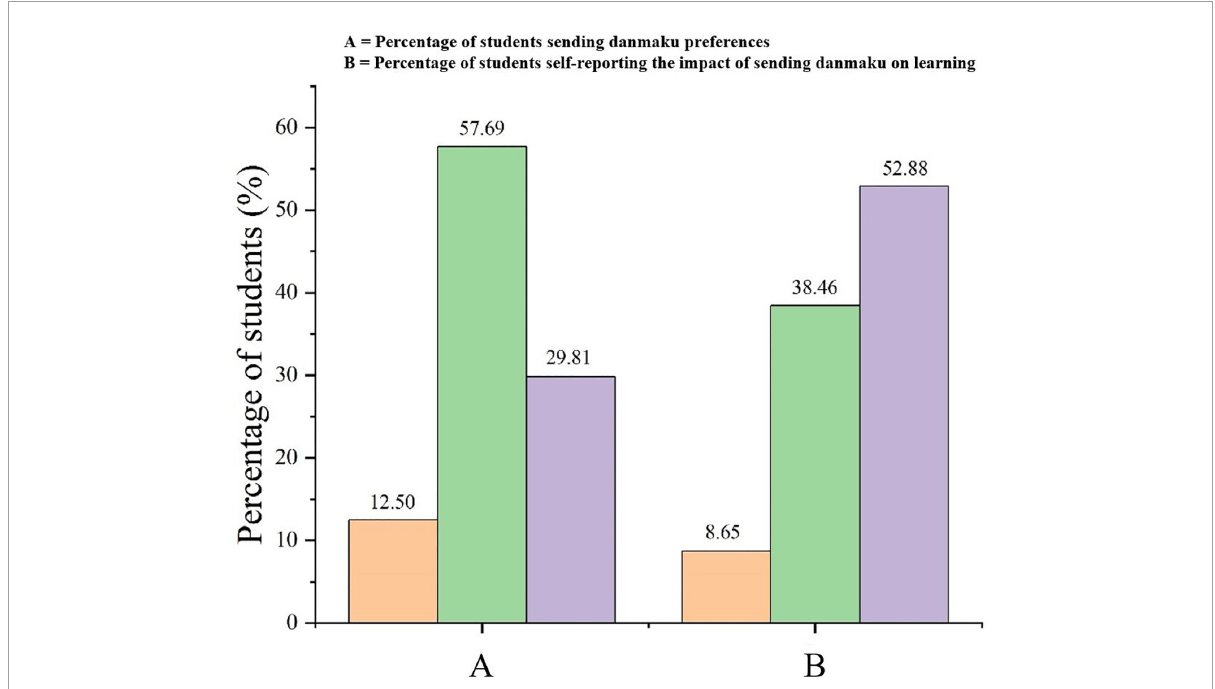
FIGURE3 Learner expectations regarding the impact of sending danmaku during instructional videos. (A) Differences in retention across experimental conditions and (B) differences in transfer across experimental conditions.